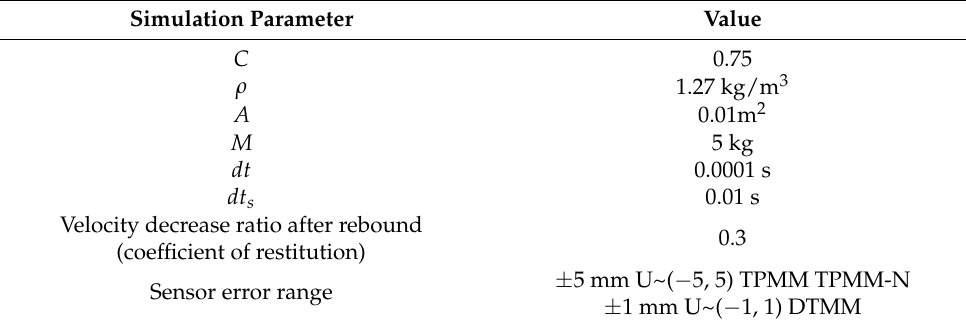
Table 1. Values of simulation